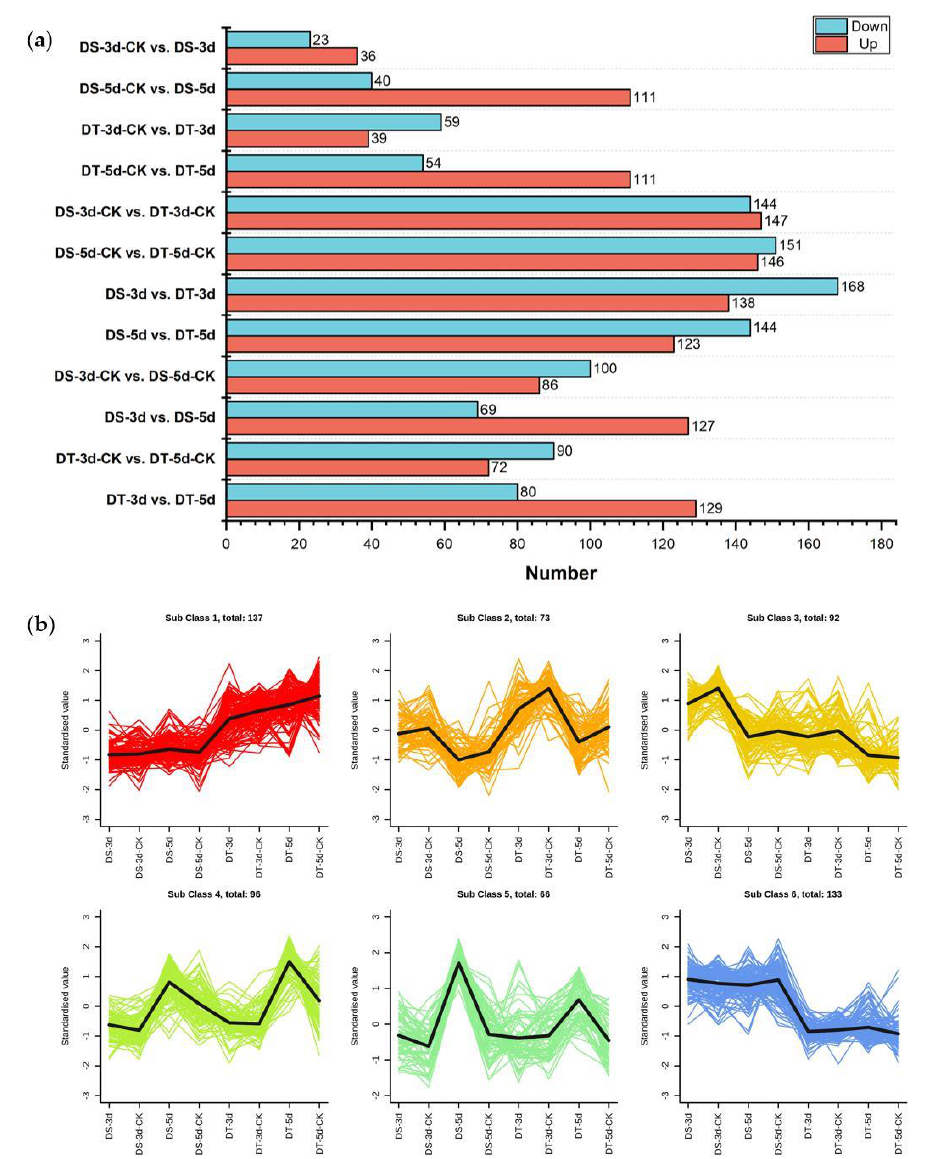
Figure 3. Analysis of differential metabolites (DMs). ( a ) Number of upregulated and downregulated DMs in 12 comparison groups; ( b ) The K − means analysis of DMs.